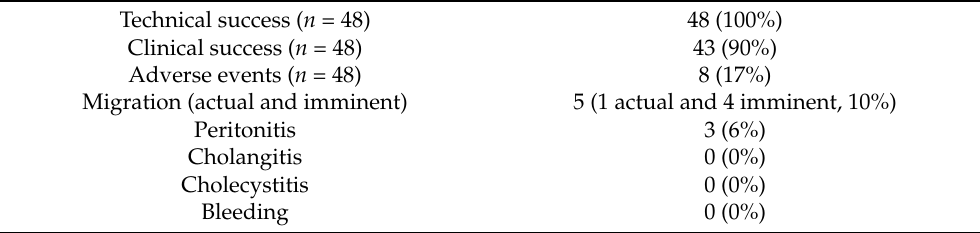
Table 3. Treatment